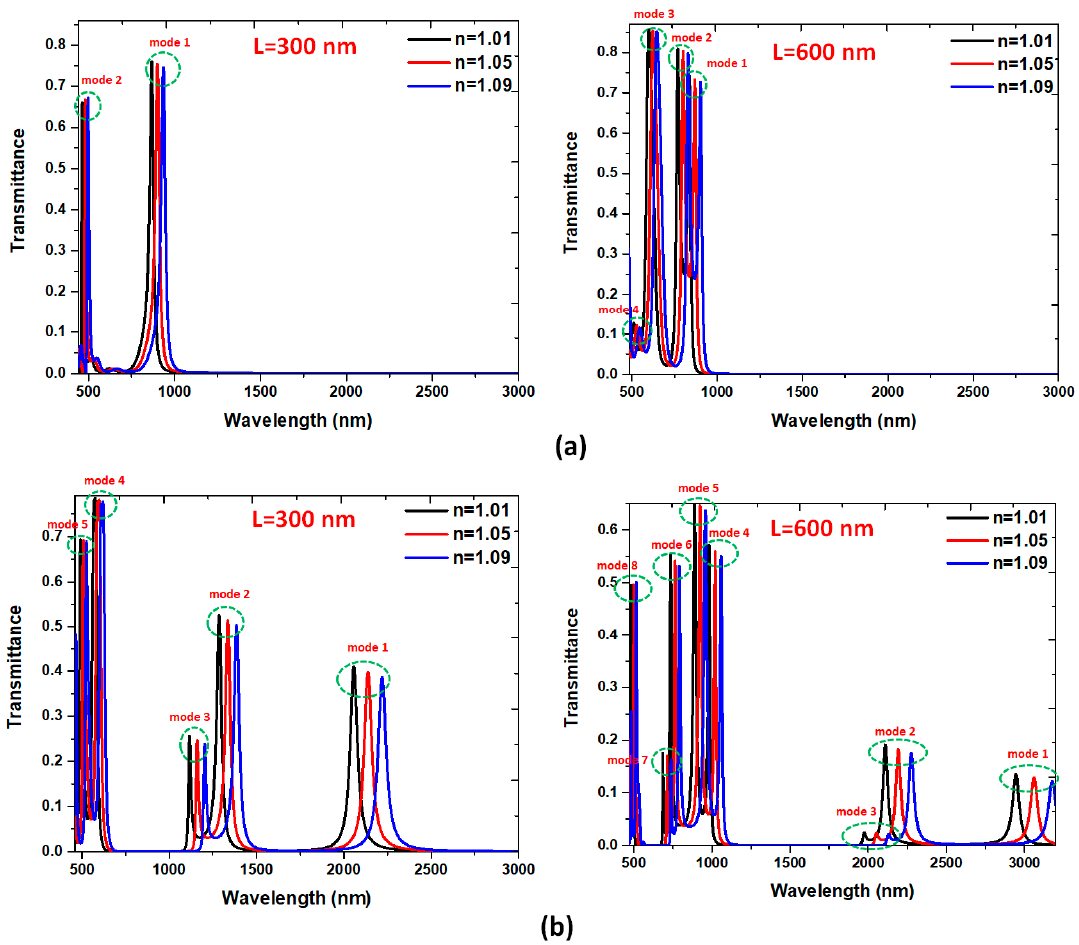
Figure 5. Transmittance spectra of the proposed plasmonic sensors ( a ) without and ( b ) with Ag baffles concerning L = 300 nm and L = 600 nm. The refractive index (n) is varied from 1.01, 1.05 to 1.09 at the interval of 0.04, respectively, while the other structural parameters w, g , and d are 50, 10, and 30 nm,